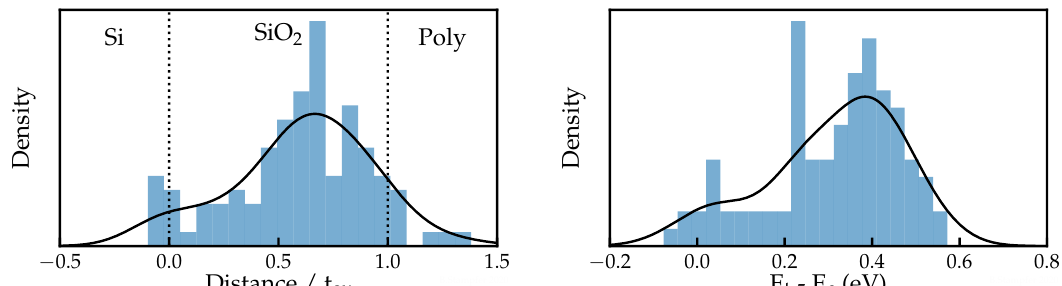
Figure 7. Distributions of positions and trap levels extracted using Equation (8) and Equation (11). Note that the measured distribution in position should not be interpreted as the complete distribution of defects in the device. It is rather a result of the energetic distribution of the defects in conjunction with the characterization window, which is diagonal in energy and distance, given by the Fermi level at measurement conditions.